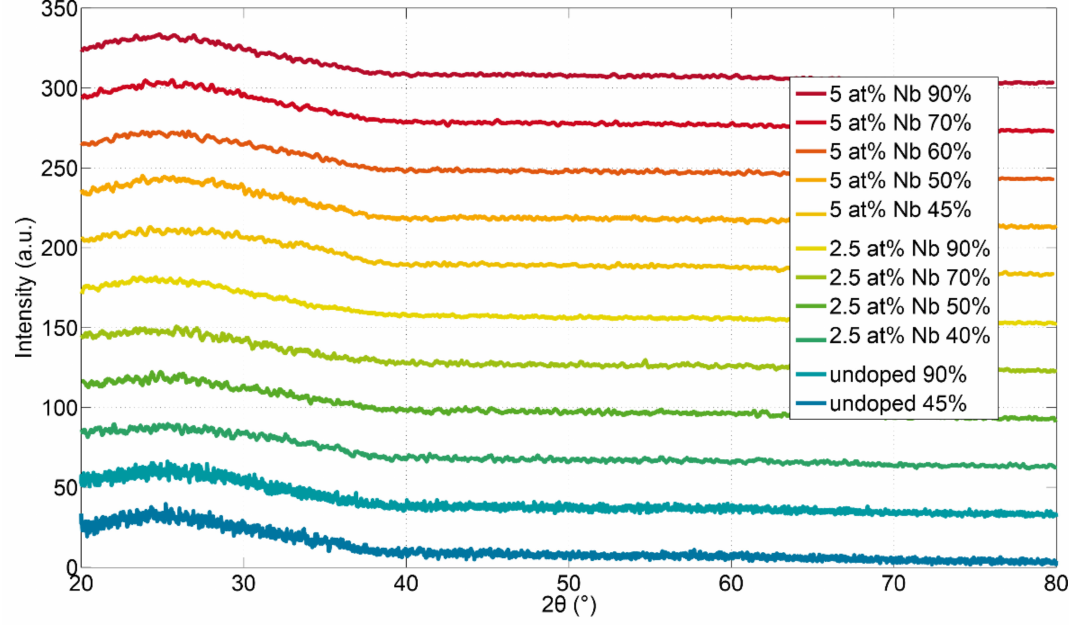
Figure A1. XRD in grazing incident geometry of as-deposited films with and without Nb doping confirming the amorphous structure before